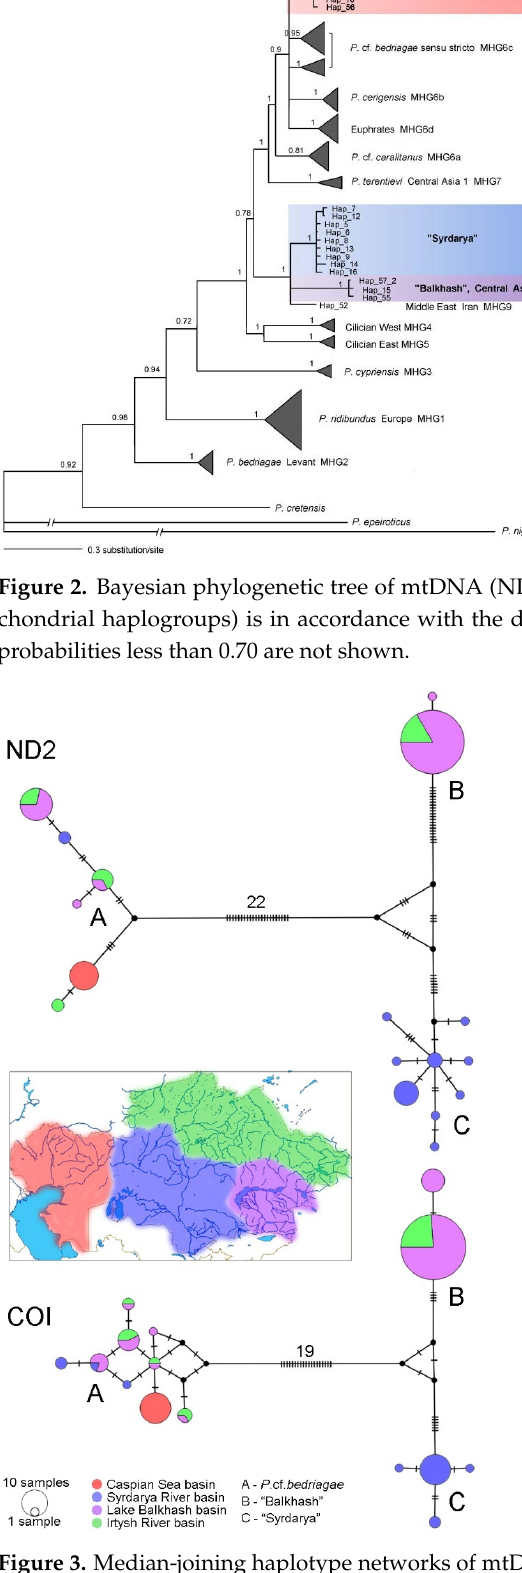
Figure 3. Median-joining haplotype networks of mtDNA lineages .